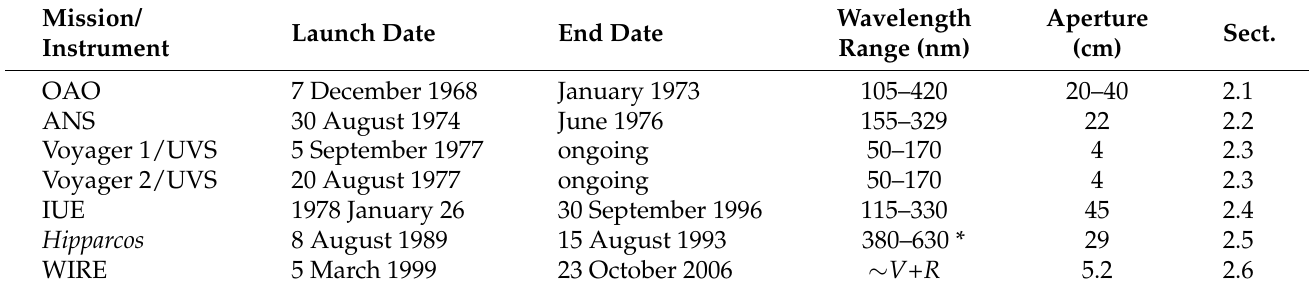
Table 1. Basic information on the space telescopes discussed in this